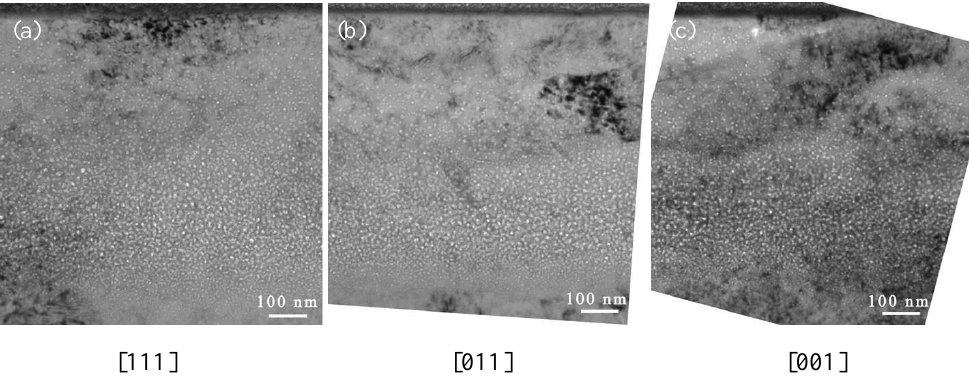
Figure 5. Low magnification of 200 keV He + irradiated Fe-15Cr-15Ni samples with different orientations ( a ) [111], ( b ) [011], ( c ) [001]. No channeling effect was observed. Due to the high-temperature irradiation, faceted helium bubbles were observed in all of the irradiated samples. Figure 6 shows the details of the faceted helium bubbles at higher magnification. As indicated by the lines and inserted diffraction patterns in Figure 6a–c, although the bubble size distribution is broad, the shape of the bubbles is faceted. There are preferential orientations for the facets (viewed along the zone axis of [011]): The edges of all of the faceted bubbles are parallel to [001], [11–1], or [–11–1].